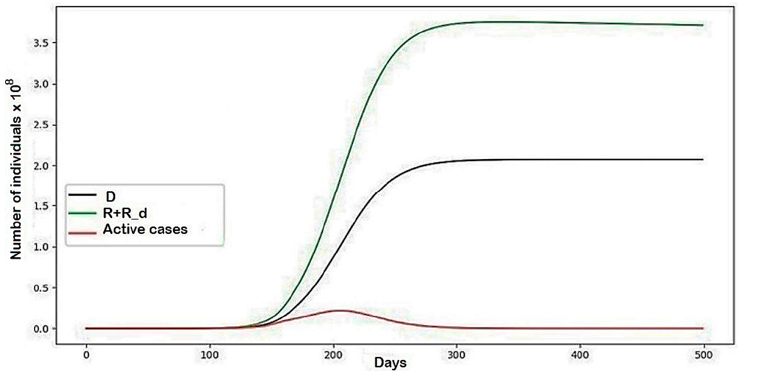
Figure A3. The modeling results describing the behaviors of the system in general with the parameters represented in Table 1.